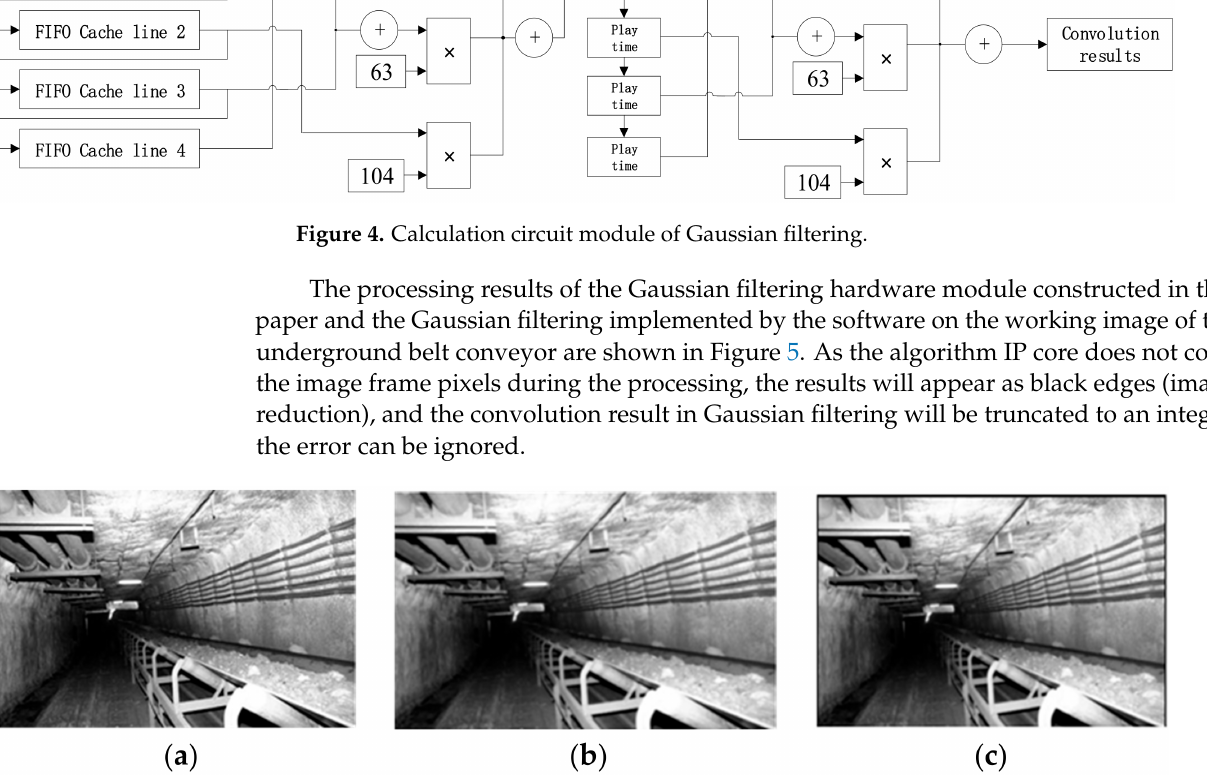
Figure 5. Comparison of Gaussian filtering results. ( a ) Original image; ( b ) software processing result; ( c ) FPGA process- ing